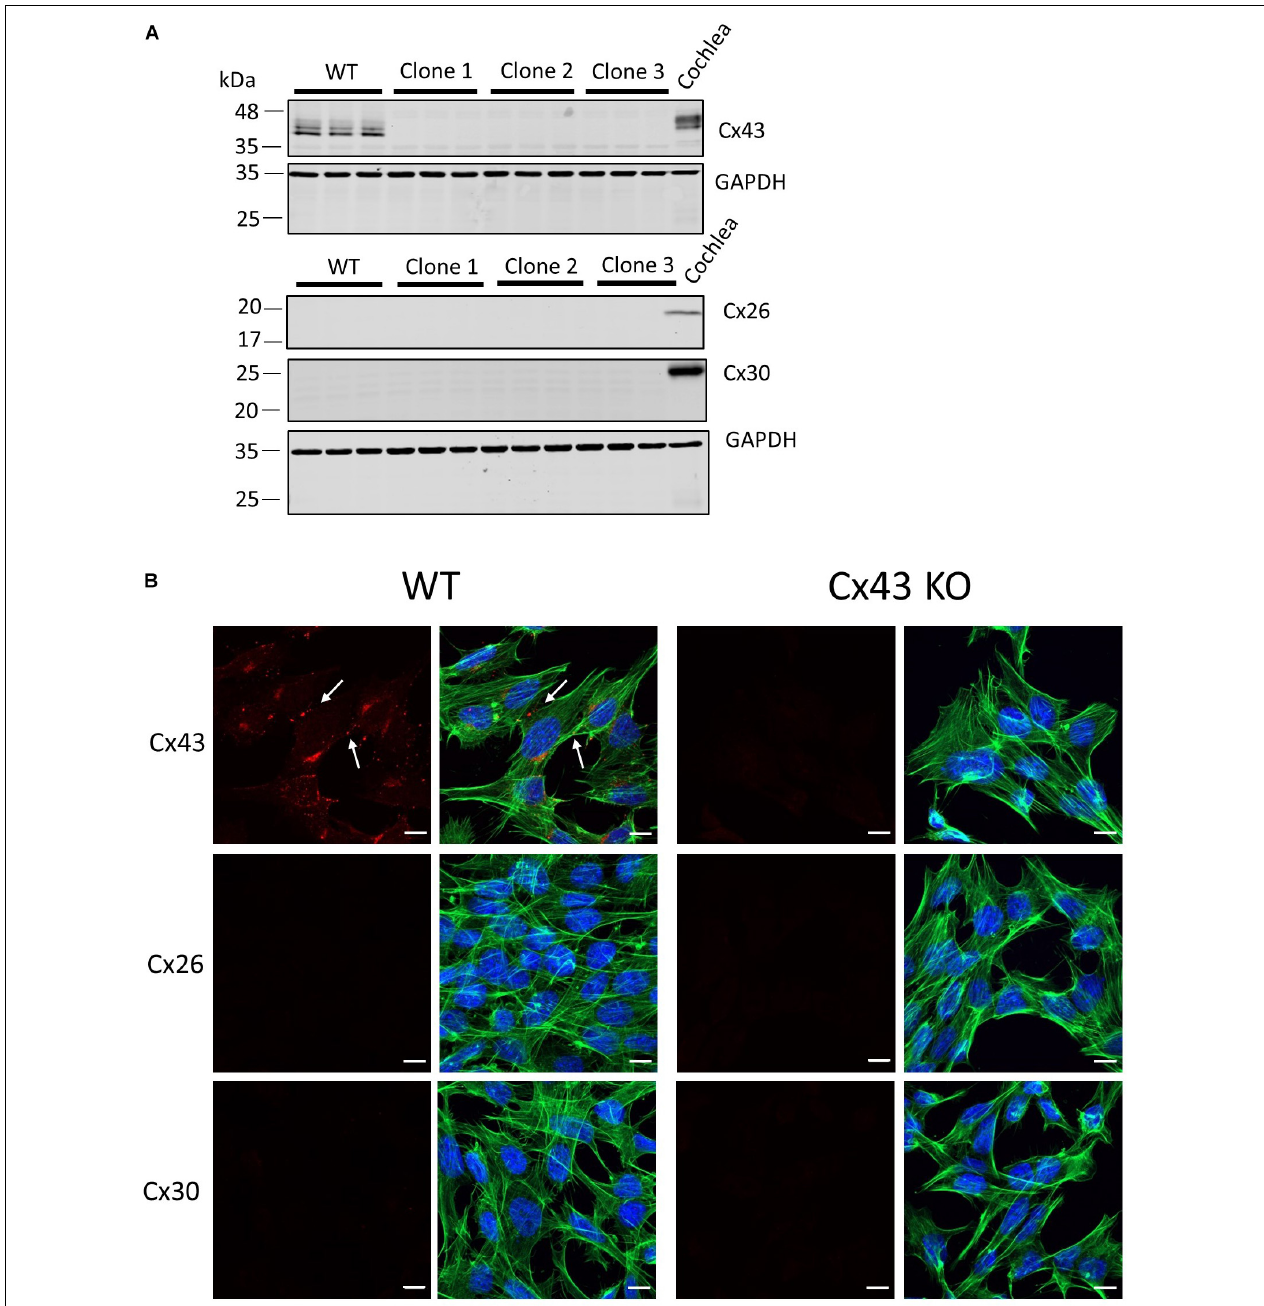
FIGURE 1 | Characterization of connexin expression and Cx43 ablation in HEI-OC1 cells. (A) Western blots for Cx43, Cx26, and Cx30 protein in wild type (WT) and three independent clones of CRISPR-Cas9 Cx43-knockout (Cx43-KO) HEI-OC1 cells where adult mouse cochlear lysate was used as a positive control. Molecular weight standards are denoted in kDa. (B) Immunolabeling revealed Cx43 gap junctions only in WT cells denoted by white arrows. Note Cx26 and Cx30 were not detected in WT or Cx43 KO cells (A,B) . Red = Cx43, Cx26, and Cx30, green = phalloidin staining of actin filaments, blue = Hoechst stained nuclei. Bars = 10 µ